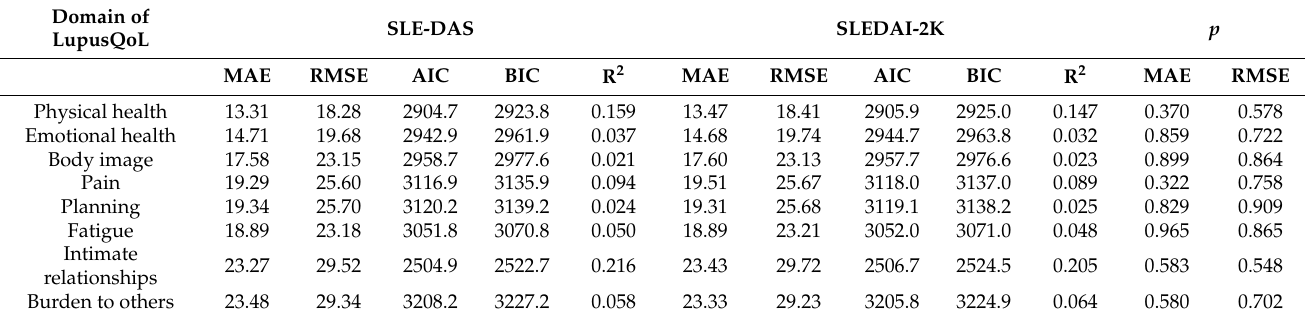
Table 5. Regression model accuracy metrics of the eight domains of Lupus Quality of Life (LupusQoL) with Systemic Lupus Erythematosus Disease Activity Score (SLE-DAS) and Systemic Lupus Erythematosus Disease Activity Index 2000 (SLEDAI-2K) adjusted for age and